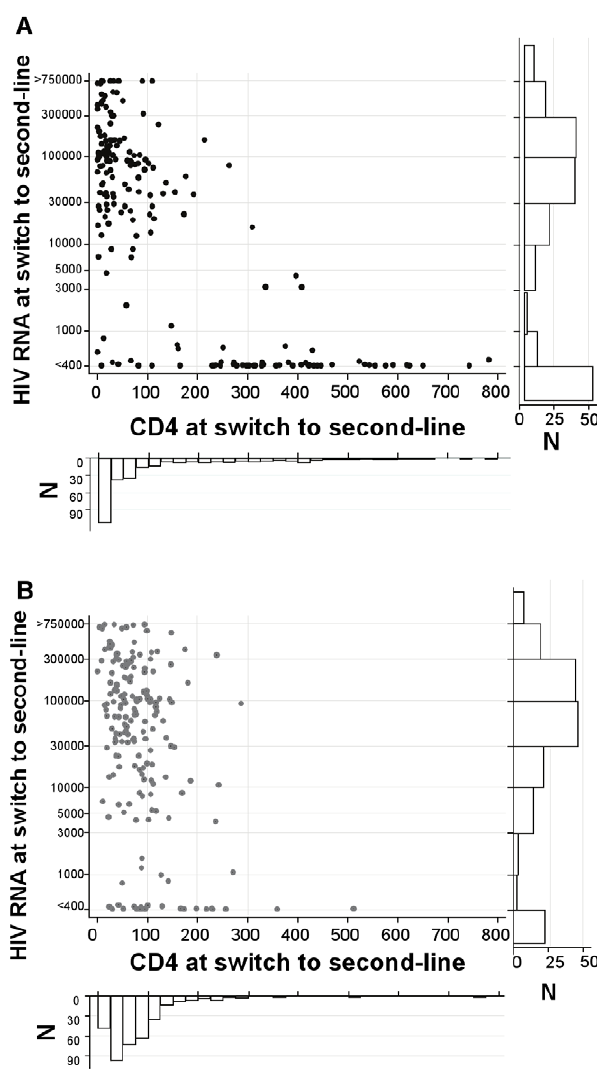
Figure 1. VL and CD4 at switch to second-line for first-line failure in patients receiving and not receiving CD4 count monitoring. (a) in patients not receiving routine CD4 count monitoring (CDM: 20% . 250 cells/mm3). (b) in patients receiving routine CD4 count monitoring (LCM: 2% . 250 cells/mm3). Footnote 1 Points at . 750000 and , 400 have a small amount of ‘jitter’ added so that all observations are visible.